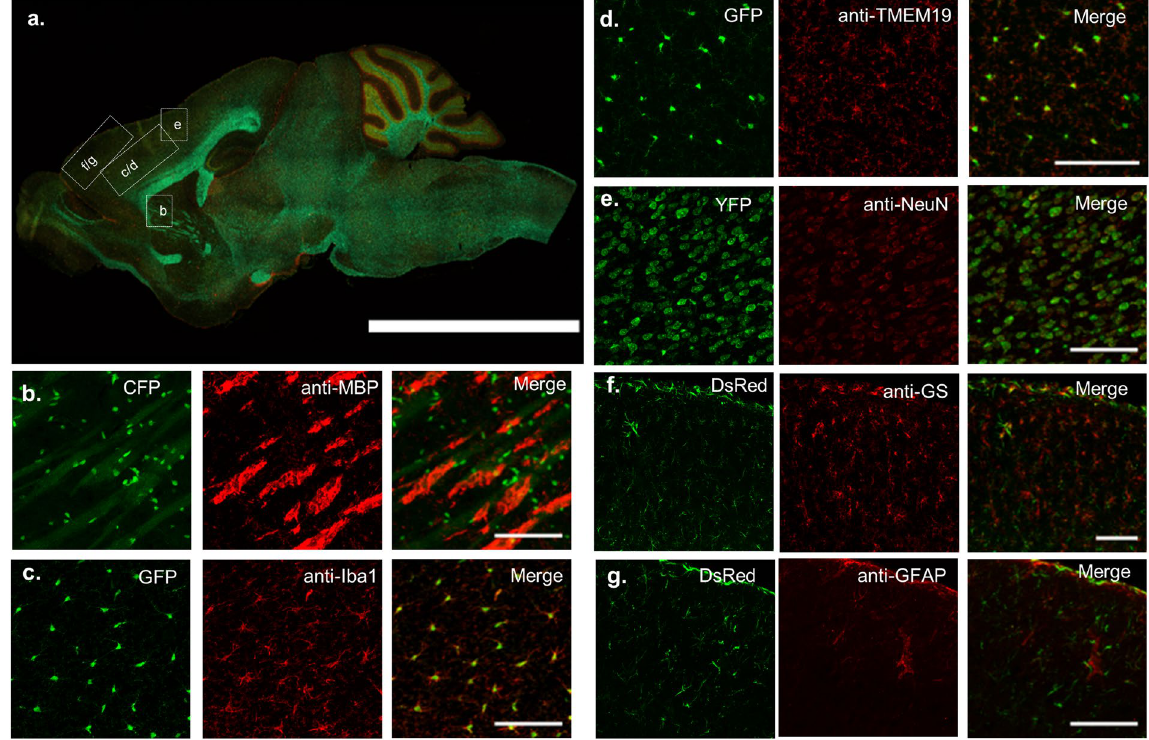
Figure 3. Co-localization of transgenic fluorophores with standard antibodies for different cell types. ( a ) Epifluorescence image of a sagittal mouse brain section illustrating approximate brain regions for images in b–g. ( b ) CFP-expressing oligodendrocytes co-occur with anti-MBP in white matter region of the brain. GFP- expressing microglia co-localized with anti- Iba1 (M1 = 0.824, M2 = 0.599) ( c ) and anti-TMEM19 (M1 = 0.806, M2 = 0.584) ( d ). ( e ) YFP-expressing neurons co-localized with NeuN (NeuN/YFP = 0.93, YFP/NeuN = 1.07). DsRed-expressing astrocytes co-localized with anti-glutamine synthetase (anti-GS) (M1 = 0.986, M2 = 0.692) ( f ) and anti-GFAP (M1 = 0.895, M2 = 0.573) ( g ). Different regions in the brain were selected to highlight specific cell’s distribution. Co-localization experiments was repeated at least on 3 different mice from different litters. M1 represents fraction of transgenic fluorophores overlapping immunostained cells and M2 represents fraction of immunostained cells overlapping transgenic fluorophores. Scale bar in a = 5 mm; b–g = 100 µ